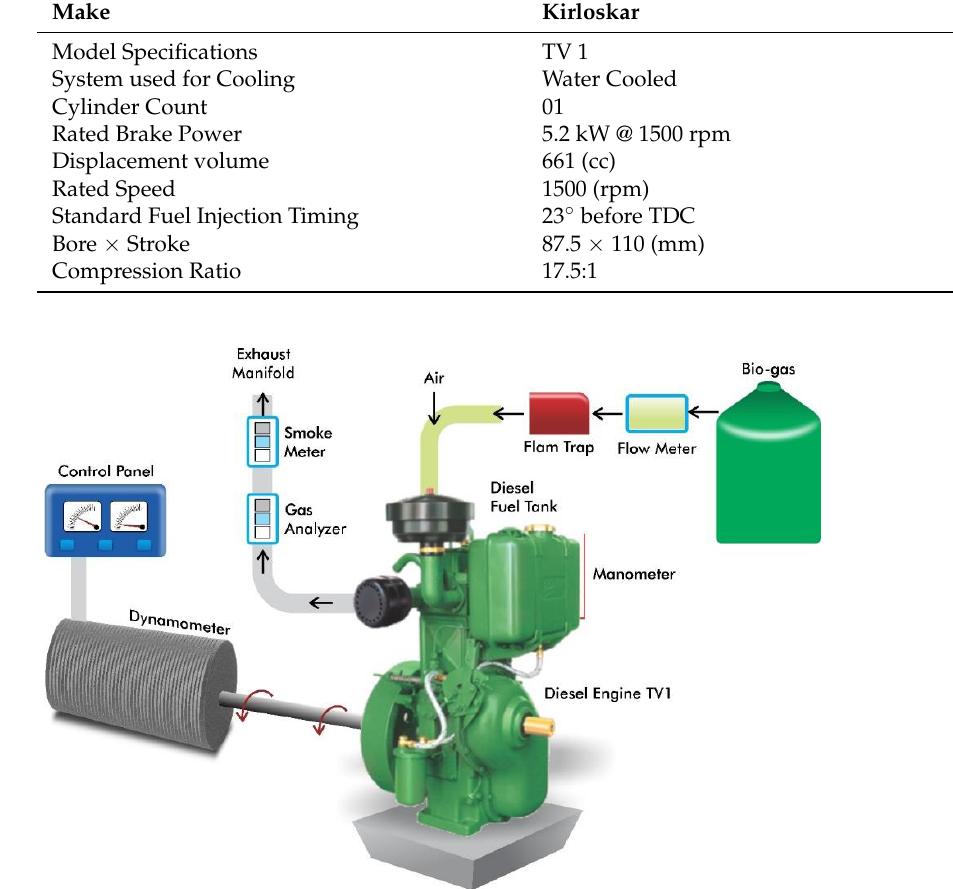
Figure 1. Diagrammatical depiction of the experimental setup used.